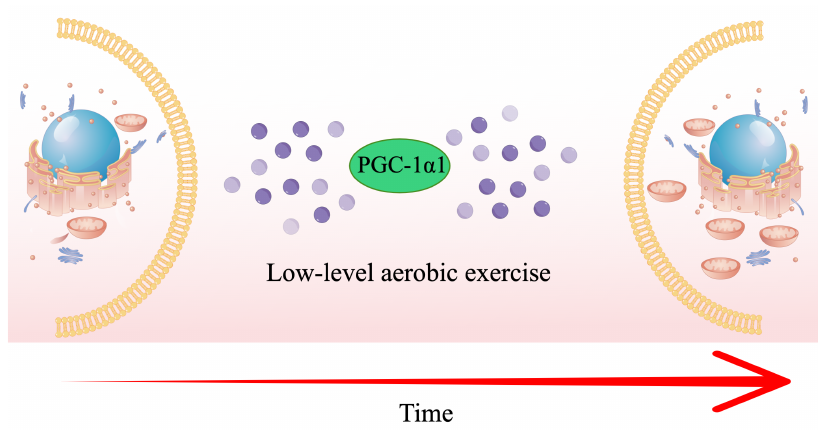
Figure 8. Schematic of the Major Signaling Pathways Involved in the Control of Mitochondrial